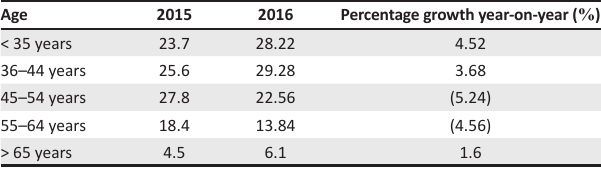
TABLE 3: Percentage age breakdown of salespeople.